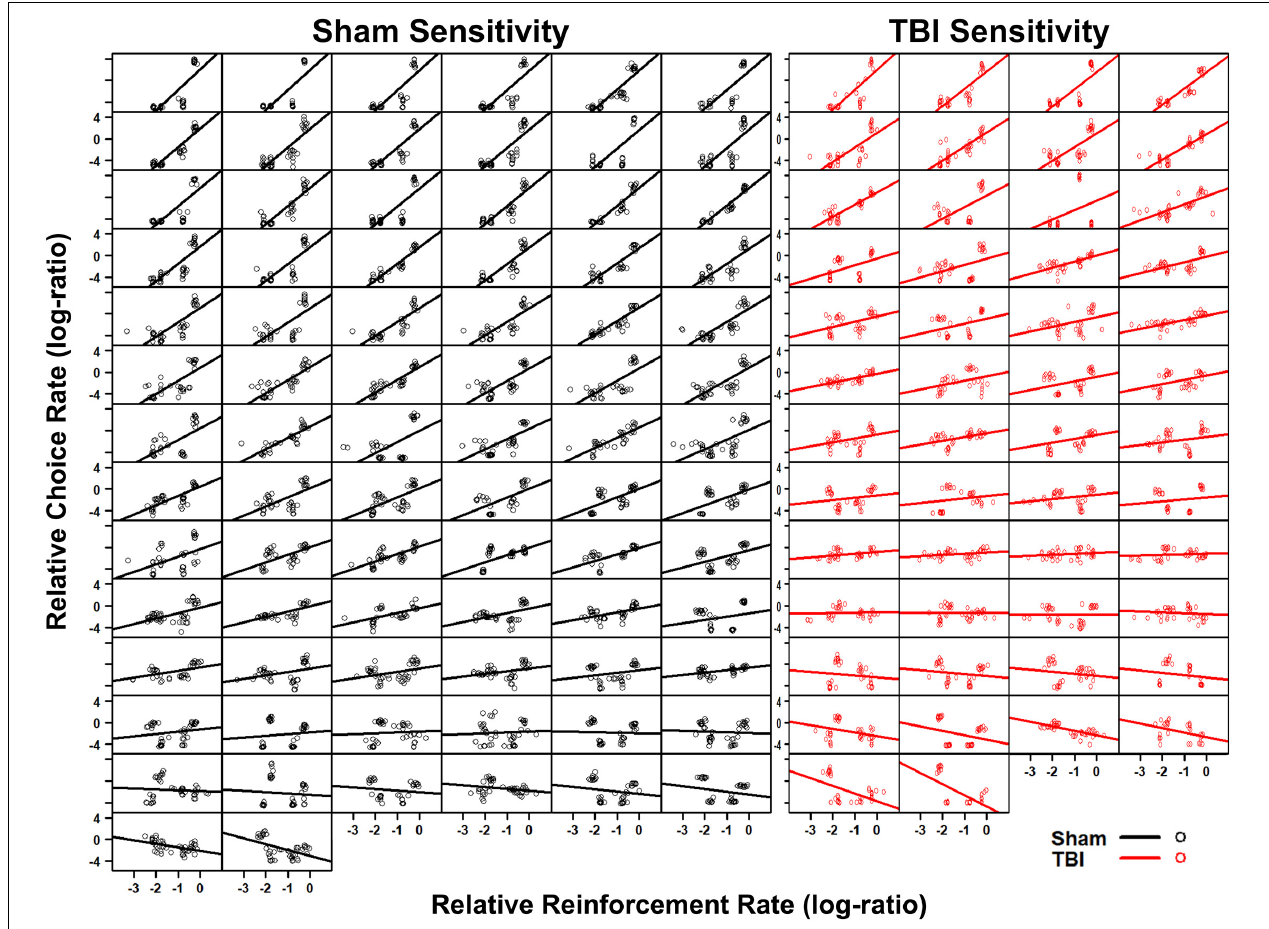
FIGURE 2 | Individual subject fits to the matching law show Sham (left, black) and TBI (right, red) subjects. A wide degree of sensitivity was present across subjects. The matching law only described a very small subset of animals.